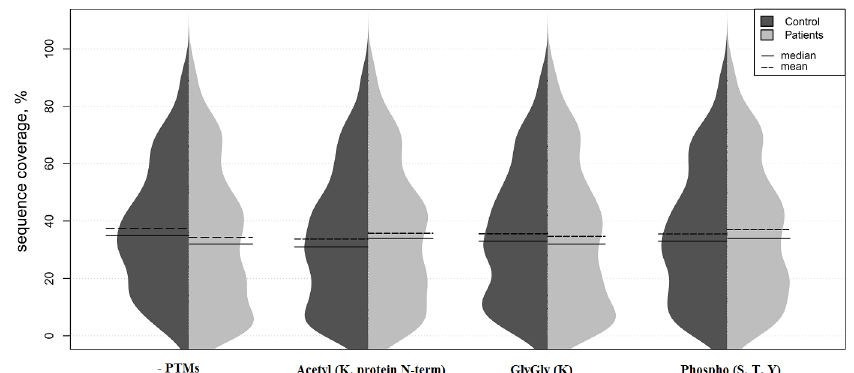
Fig 1. Sequence coveragefor various protein PTMs. Identification by Mascot of (cid:21) 3 peptides per protein. The adjusted inversenormalizedvalues are displayedas a violinplot, comparing distributionsbetweencontrol and GBM samples. Horizontalbars indicatethe mean (dashedline) and median (solid line) values for each group.